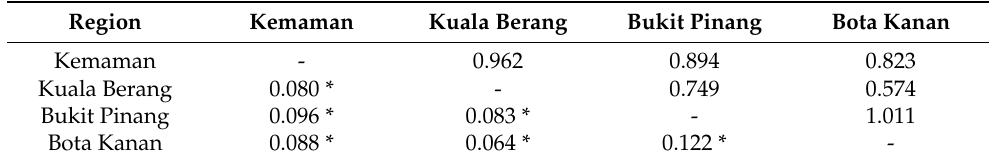
Table 2. Pairwise genetic distance based on the F ST matrix (below diagonal) and Nei Matrix (upper diagonal), a measure of divergence among the B. affinis ssp. populations. * p < 0.05. Region Kemaman Kuala Berang Bukit Pinang Bota Kanan Kemaman - 0.962 0.894 0.823 Kuala Berang 0.080 * - 0.749 0.574 Bukit Pinang 0.096 * 0.083 * - 1.011 Bota Kanan 0.088 * 0.064 * 0.122 * -